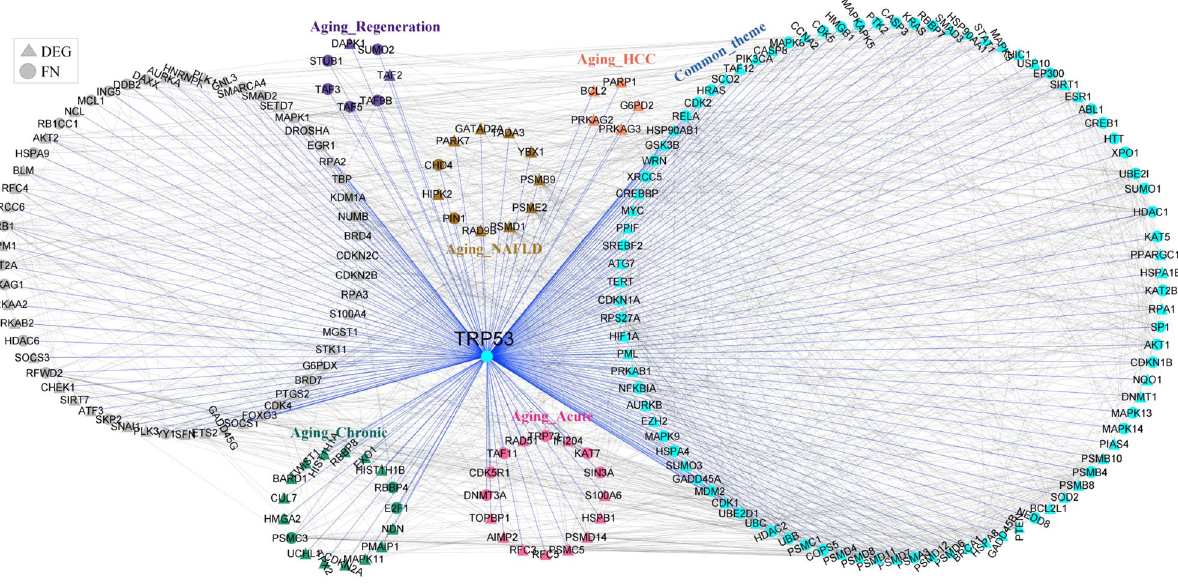
Figure 8. Interacting partners of candidate gene, TRP53, present in the common